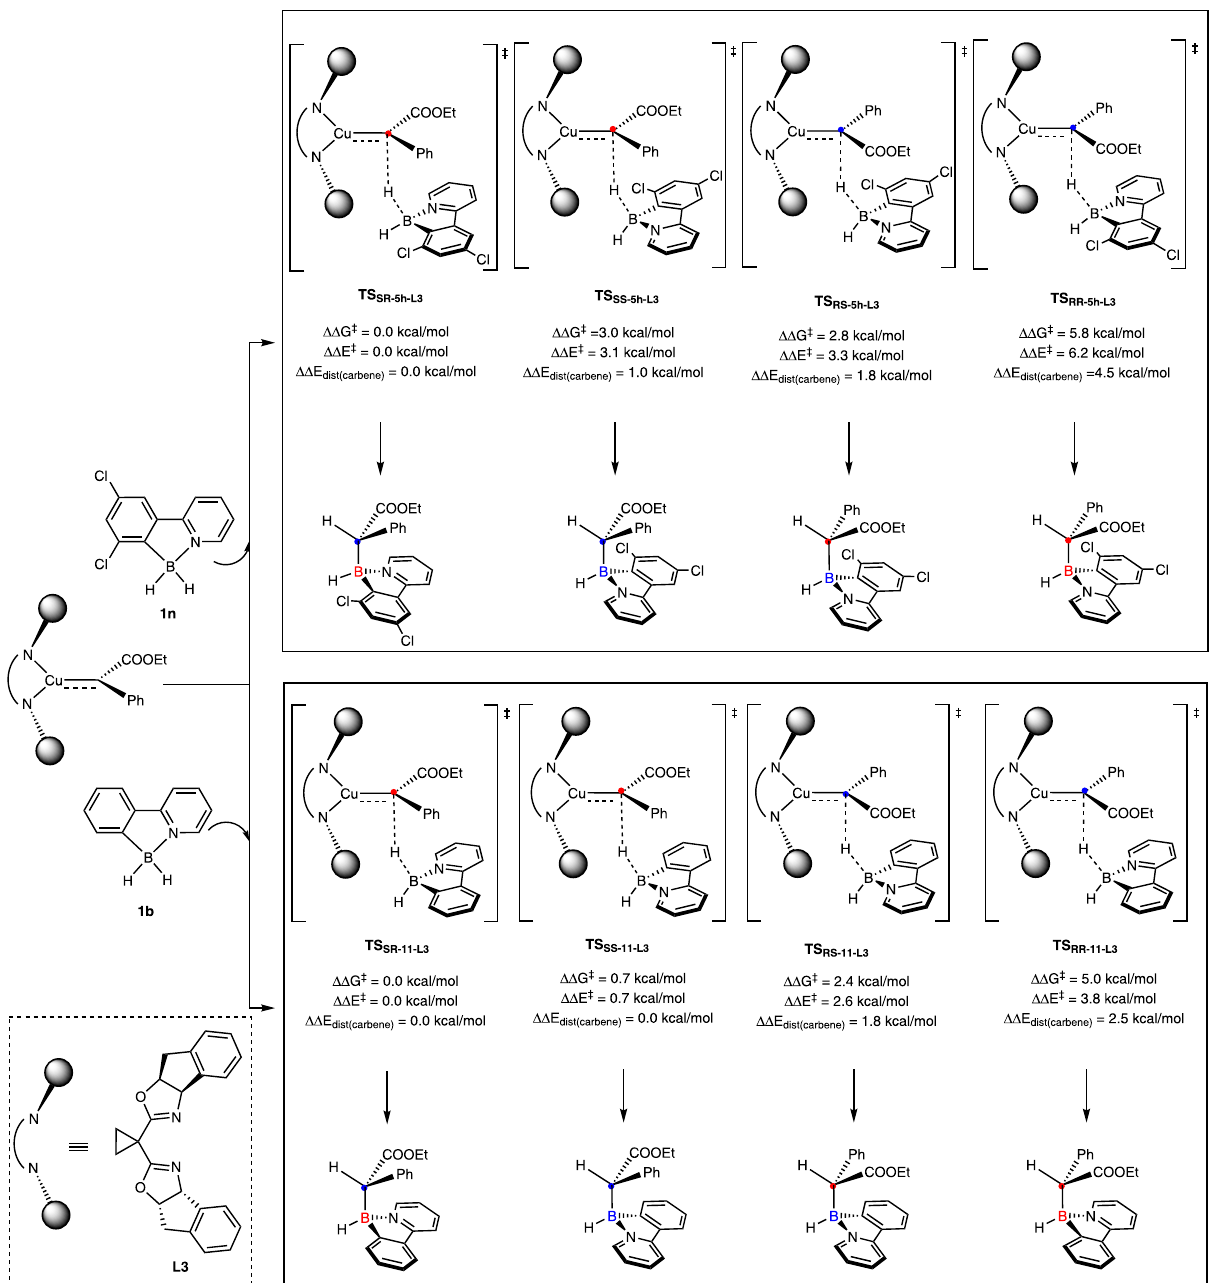
Fig. 10 Computational investigation on the construction of two consecutive chiral centers. All computational results are performed at the M06/SMD/ def2TZVP//B3LYP/SMD/def2SVP level of